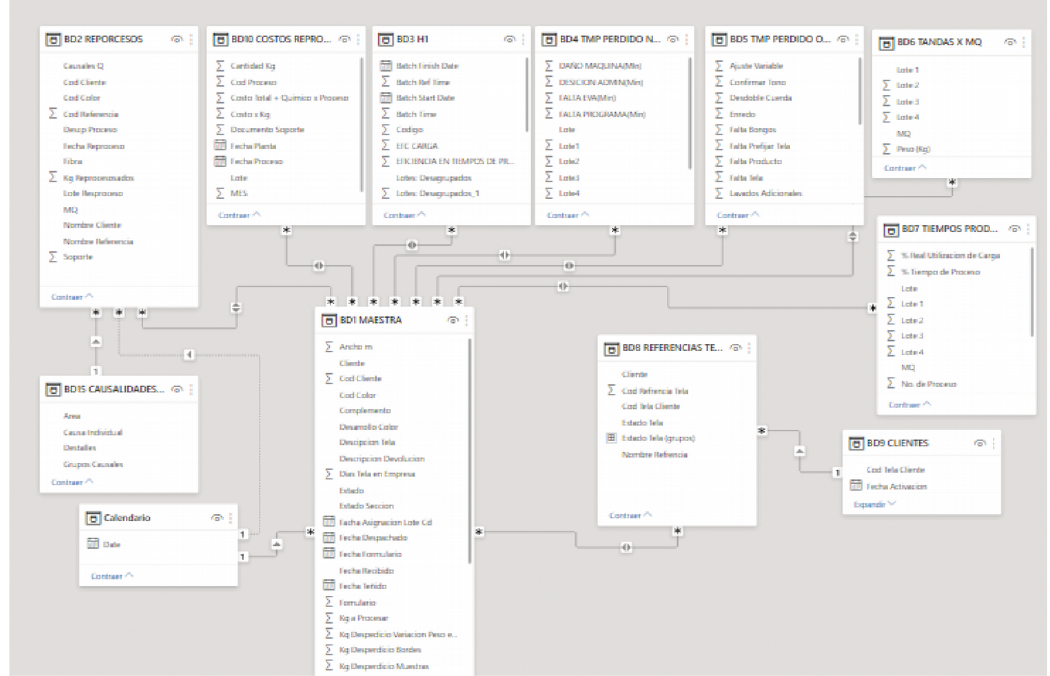
Figure 8. Logical model of related databases in Power BI